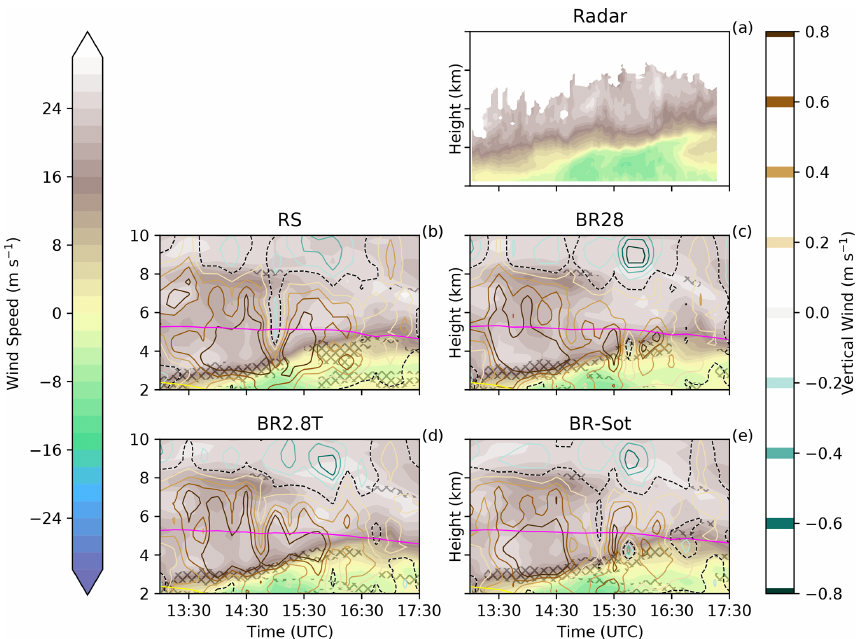
Figure 2. Hovmöller diagrams of wind speed and vertical velocity for panels (a) Doppler radar, (b) RS, (c) BR28, (d) BR2.8T and (e) BR- Sot between 13:00 and 17:30UTC. The filled contours denote wind blowing towards (blue and green) and away (white and brown) from the radar, respectively. The pink line is the − 21 ◦ C isotherm. At warmer temperatures collisional breakup occurs. Hatching denotes the region where the air layer is dynamically unstable, determined by a bulk Richardson number of less than